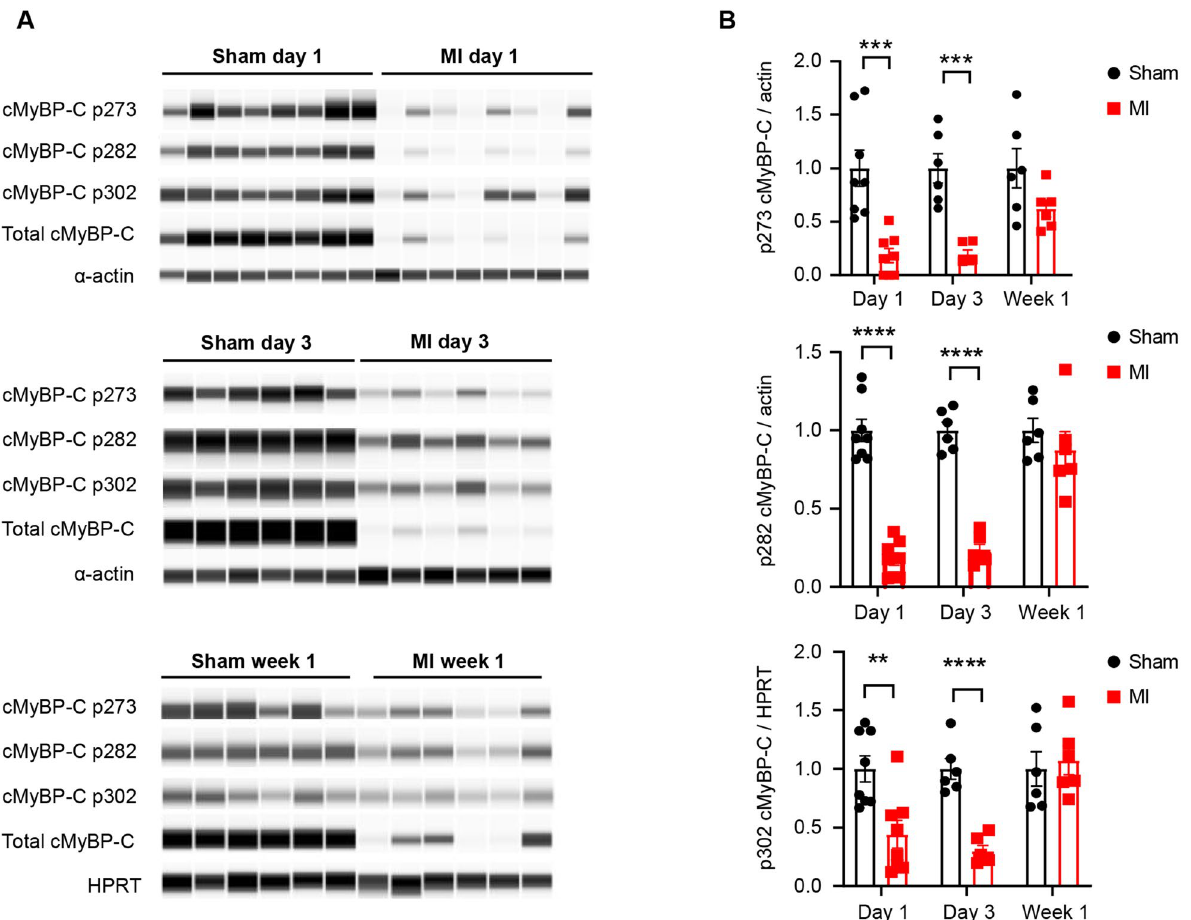
Figure 1. cMyBP-C phosphorylation was reduced at day 1 and day 3, but not at week 1 in post-MI rats compared to sham. ( A ) Western blot (Wes) of phosphorylated cMyBP-C tested with site-specific phospho cMyBP-C antibodies p273, p282, p302, total cMyBP-C antibodies, and housekeeping protein antibodies alpha- actin or HPRT . Whole homogenates from left ventricular infarct tissue from MI rats and the same area from sham rats were used for Wes. Each lane represents one individual capillary loaded with the same amount of proteins. Original full length Wes images are presented in Supplementary Figs. S3–S5. ( B ) Quantification of cMyBP-C p273, p282, and p302 normalized to housekeeping proteins. Data represent means ± SEM (N = 6–8). ** p < 0.01; *** p < 0.005; **** p < 0.001; unpaired two-tailed Student’s